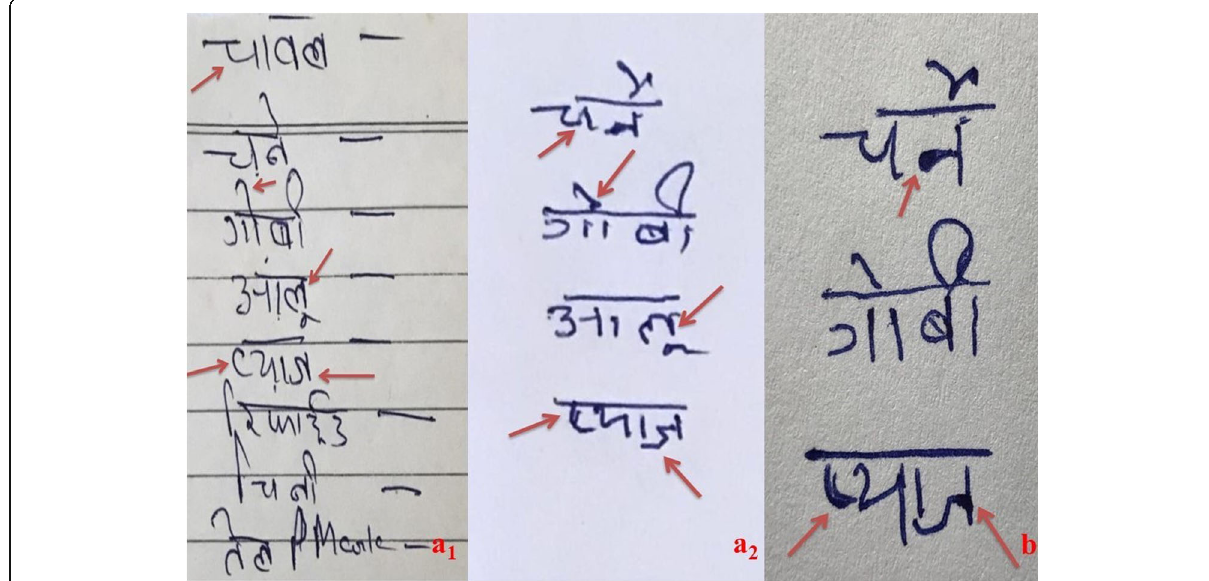
Fig. 5 Omission of letters and words. a 1 Handwriting executed before onset of RA. a 2 Omission of whole words and bold overwritten strokes in handwriting of RA patient. b Copied writing showing omission of a word and artificial drawing of overwritten strokes